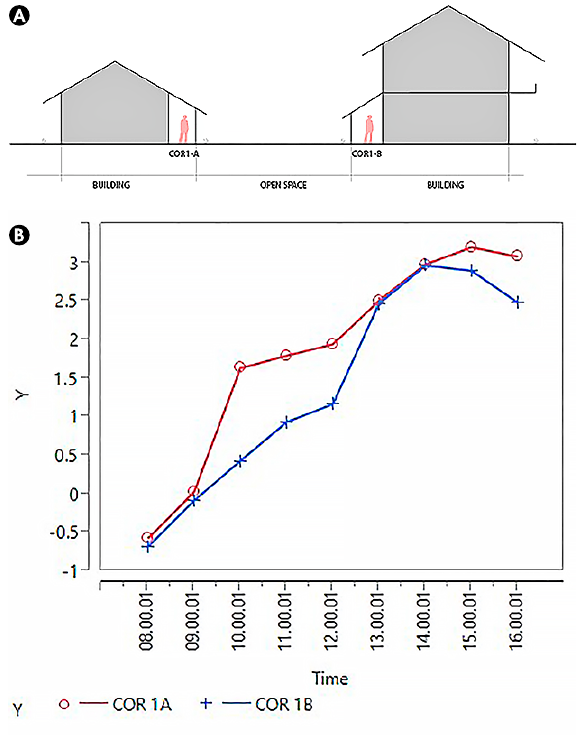
Figure 12. (a) Section of COR1A and COR1B (b) Comparison of PMV at 2 points location in the COR1 zone